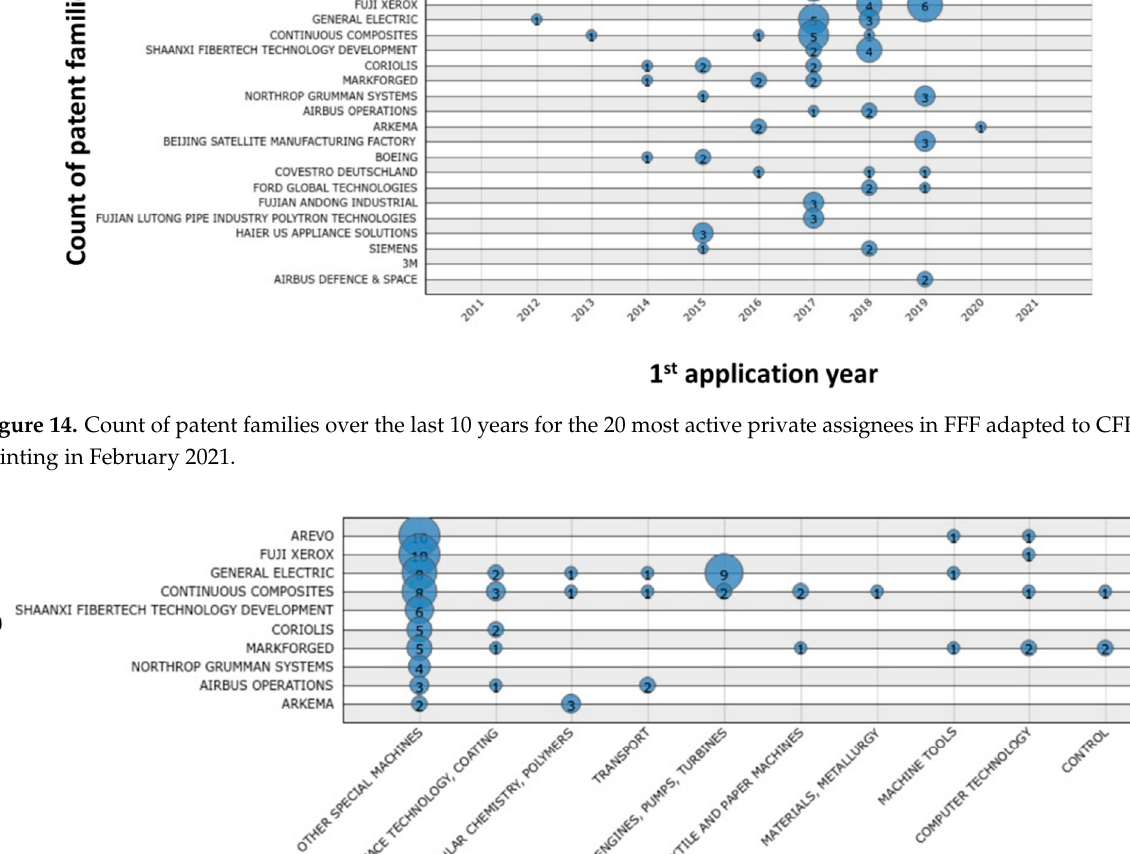
Figure 16. Count of patent families for the 20 largest institutional assignees in FFF adapted to CFRTPC printing in February 2021. Figure 17. Main technology domains covered by the 10 largest institutional assignees in FFF adapted to CFRTPC printing in February 2021.